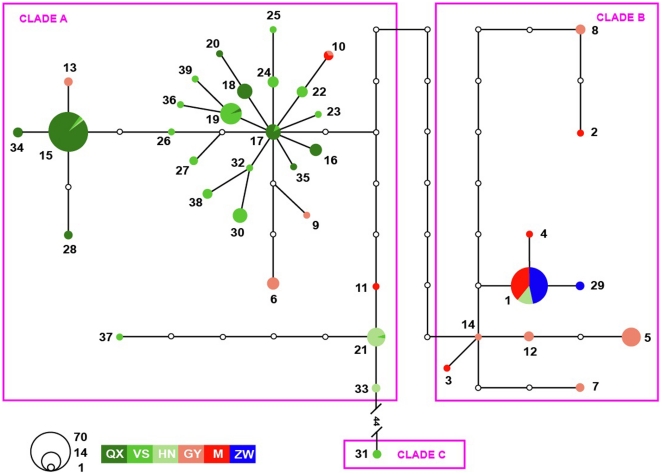
Network of 39 mitochondrial cytochrome b haplotypes from 269 individual Naja atra.The size of the circles is proportional to haplotype frequency; small open circles represent intermediate haplotypes that are not in our study. See Table 1 for sample sites abbreviations. Sites where most individuals were assigned to the same cluster on the basis of microsatellite data have gradations of the same color (s).